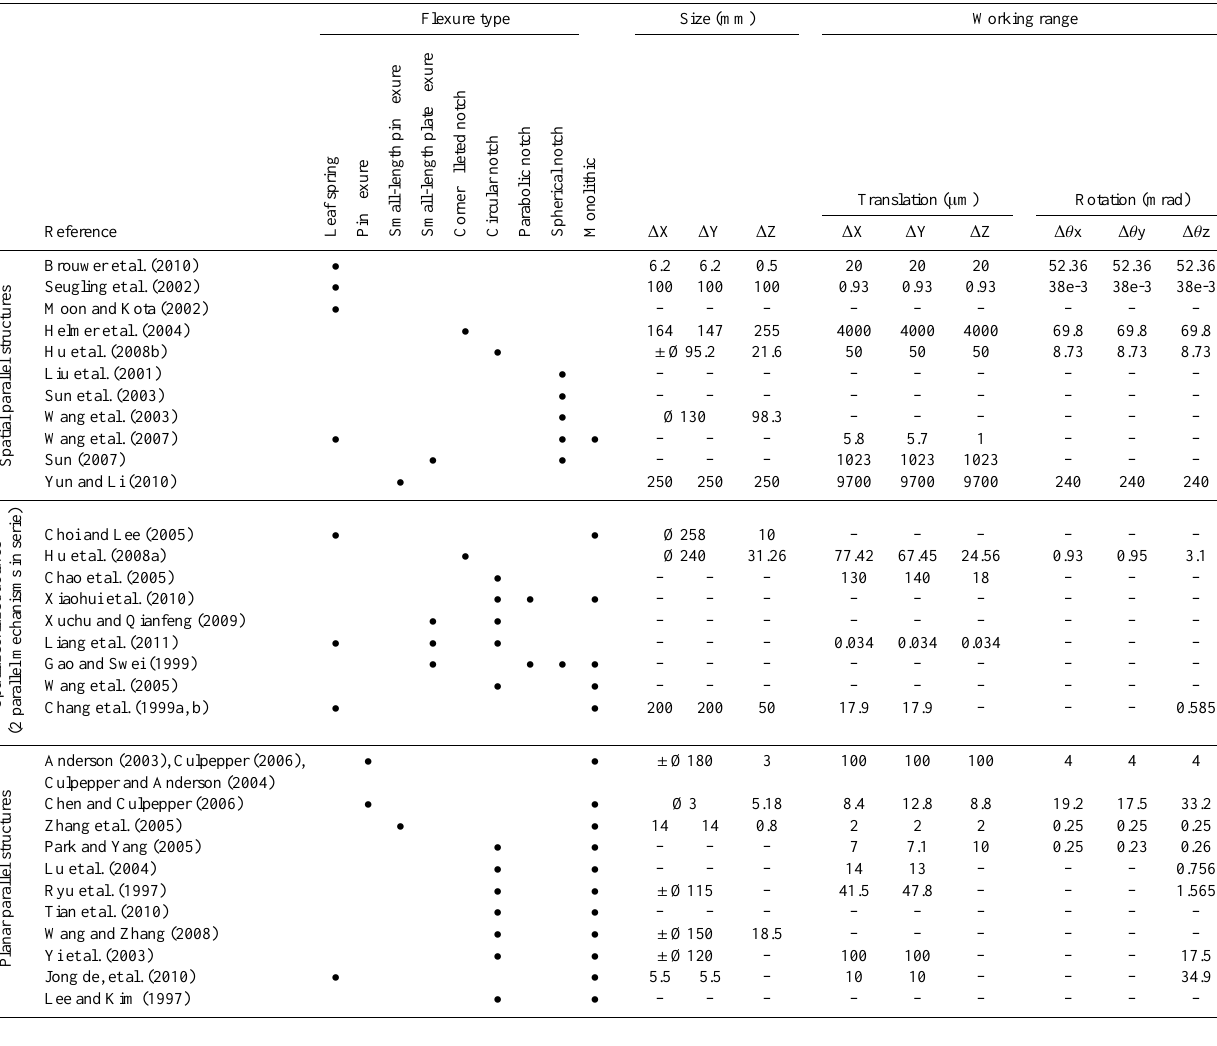
Table 2. Overview of the results of the compliant stages, mentioned flexure type (mentioned with • ), size and working range. Data not available identified with –.